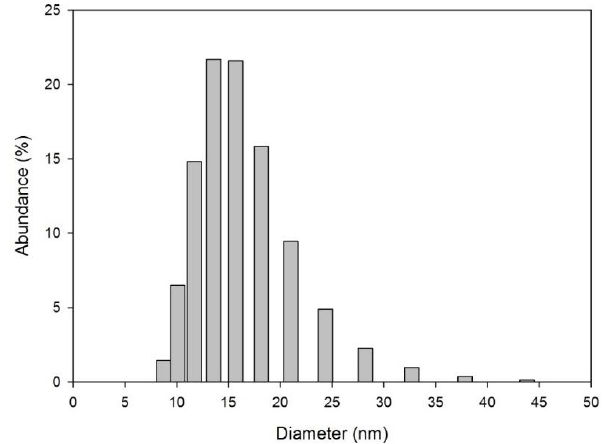
Figure 1. DLS particle size distribution of monodisperse AuNPs with an average size of 15